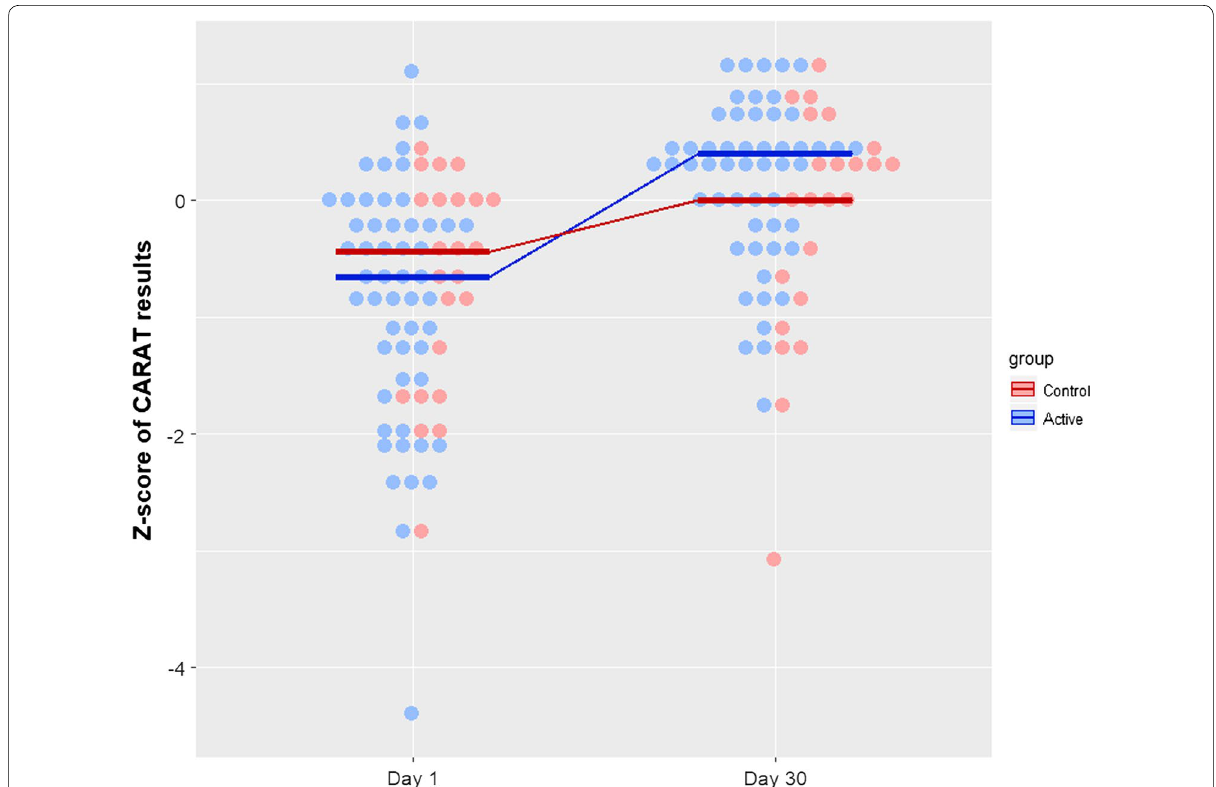
Fig. 3 Dot plot for the Z‑scores of CARAT10/CARATKids results for active and control groups on day 1 and day 30